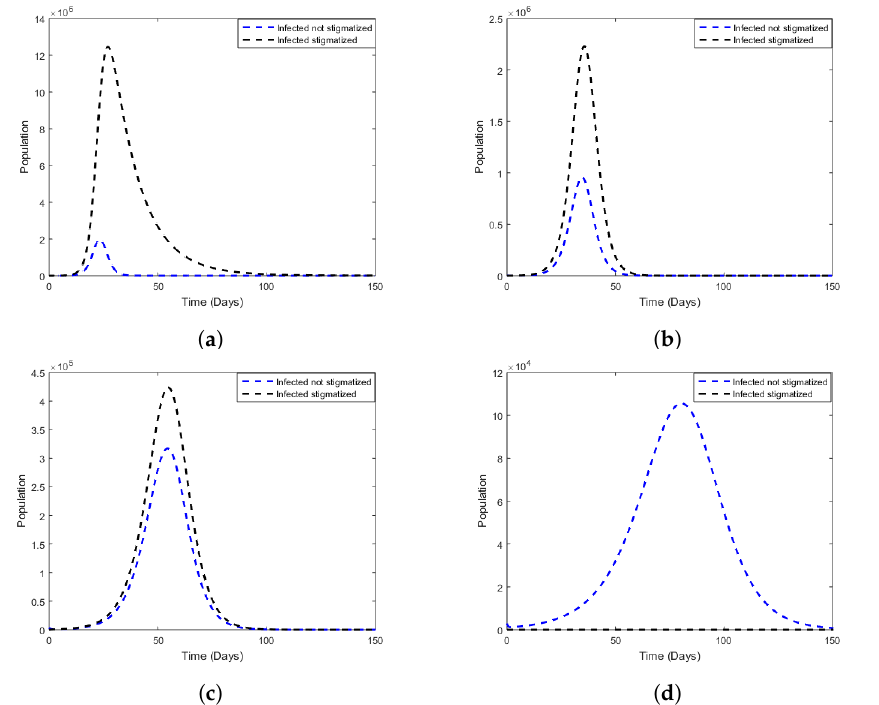
Figure 6. Comparison between non-stigmatised and stigmatised populations, varying γ for fixed values of p for the cases where there is stigma. ( a ) High stigma, γ = 0 and p = 0.49. ( b ) Moderate stigma, γ = 0.4 and p = 0.49. ( c ) Low stigma, γ = 0.8 and p = 0.49. ( d ) Stigma-free, γ = 0 and p = 0. •